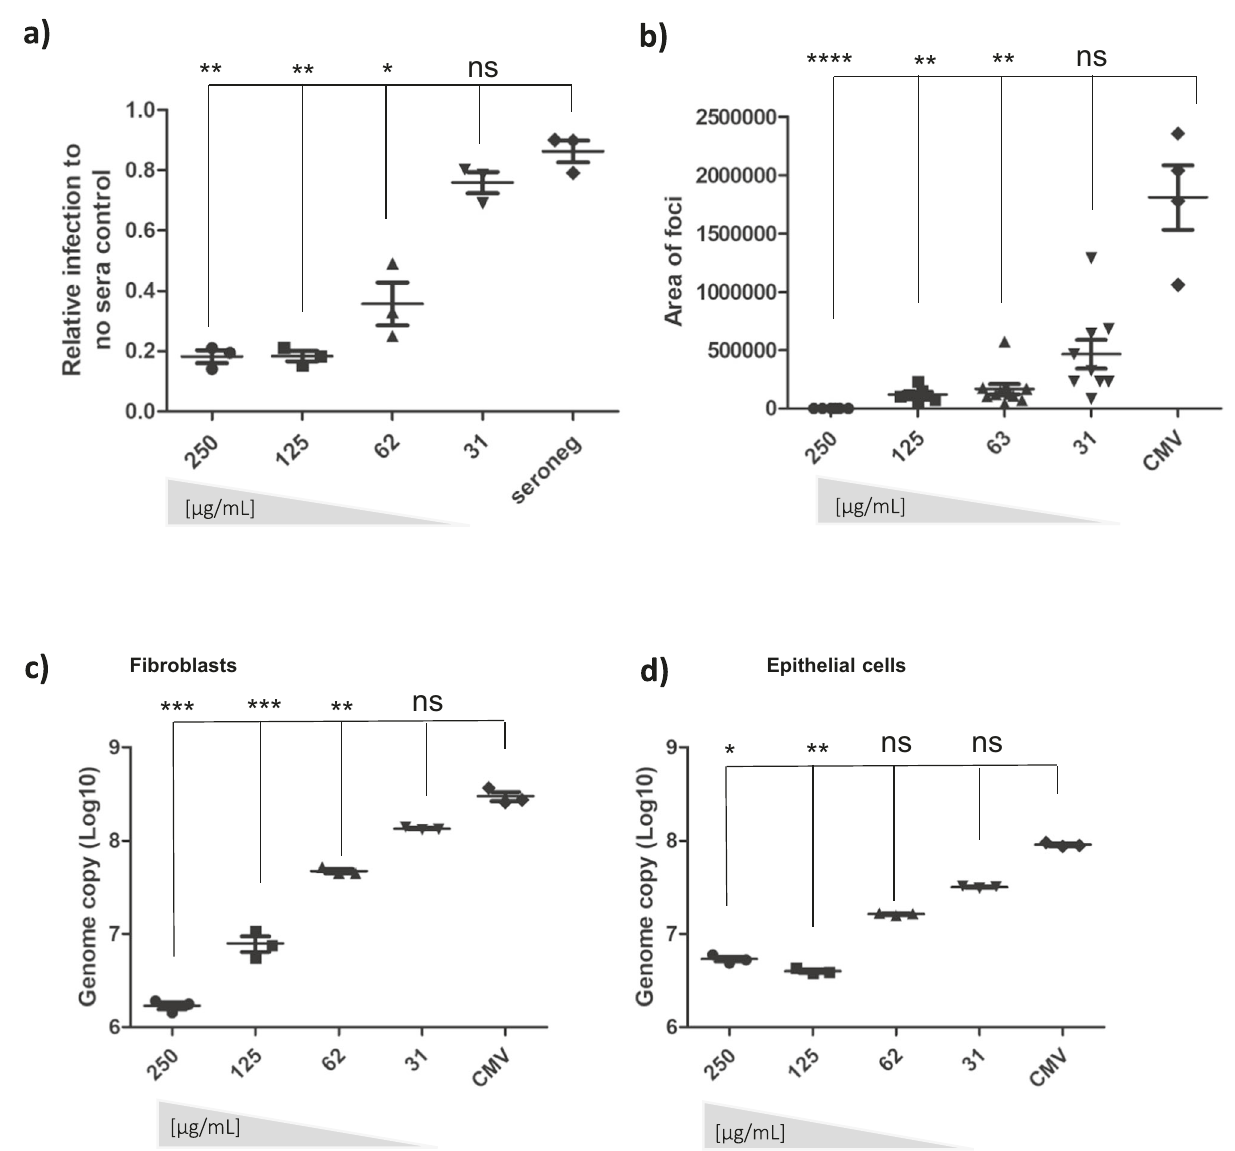
Fig. 6 | Anti-AD-6 antibodies limit cell-associated spread of CMV. a – c To mea- sure spread of cell-associated virus in HFFs, cells were infected with Merlin-IE2- GFP (MOI=0.01). At 1 dpi and 5 dpi, anti-AD-6 antibody was added at the indi- cated concentrations (plus control normal rabbit sera in A. At 10 dpi, cells were thenanalysedby IFor DNA-qPCRforviral spread.Percentage ofinfectedcells ( a ) was measured by anti-IE stain counterstained with nuclei stain and counted by automated fl uorescence microscopy ( n = 3) and expressed relative to infection seen in cells incubated with no sera. Alternatively, the area of each individual plaque identi fi ed from randomly chosen images from the three independent experiments analysed in a was measured using Fiji software ( b ). Alternatively,